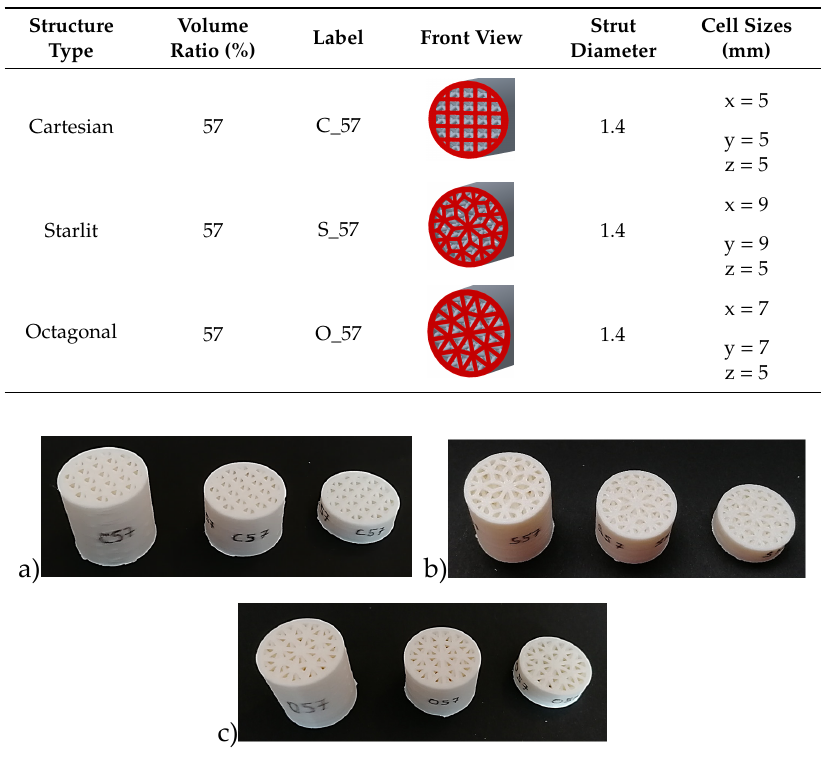
Figure 2. Tested samples: ( a ) Cartesian structure, ( b ) Starlit structure, and ( c ) Octagonal structure.